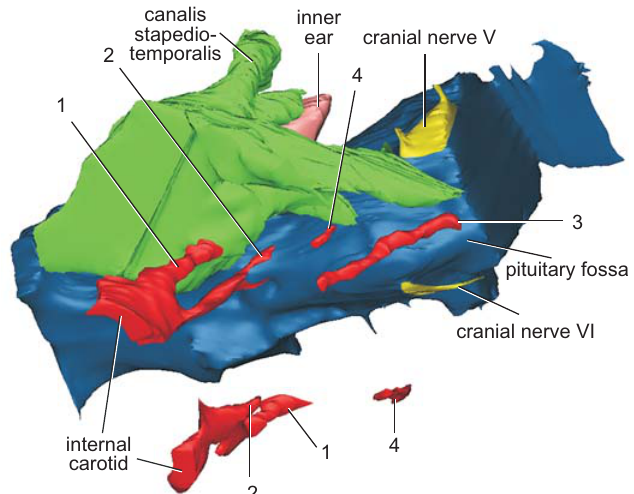
Fig. 3. Detail of the cranial endocast and blood vessels of helochelydrid turtle Naomichelys speciosa Hay, 1908 (FMNH PR273) in right latero- ventral view. The image also includes the cavum acustico-jugulare, right inner ear, and cranial nerves V and VI. 1, lateral branch of the internal ca- rotid artery; 2, anteromedial branch of the carotid artery; 3, cerebral artery; 4, ?unnamed branch of the nervi vidiani. Not to